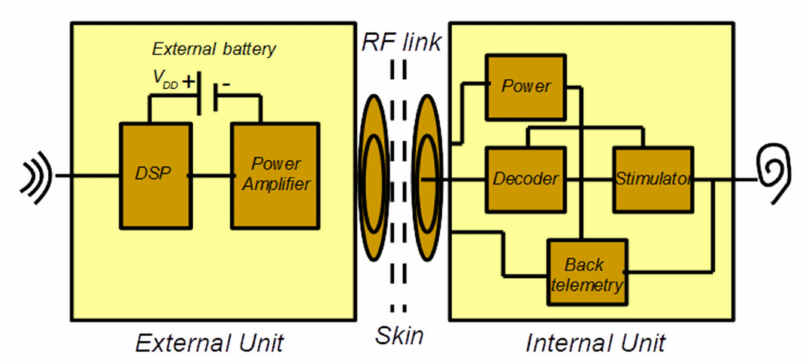
Figure 1. Schematic block diagram for the cochlear